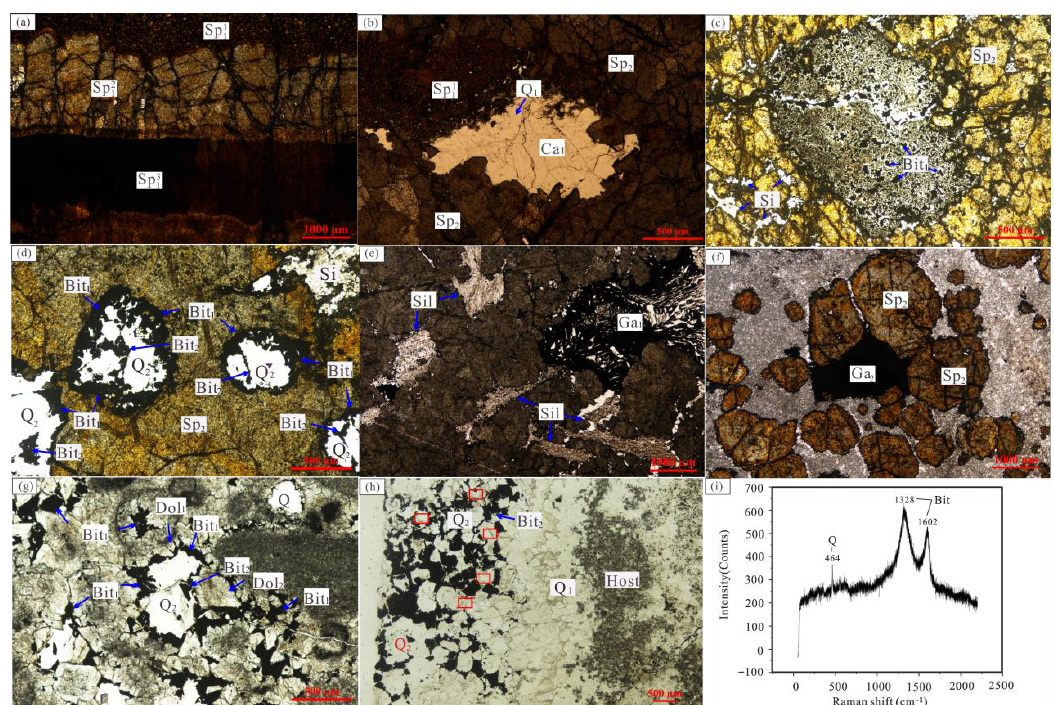
Figure 5. Photomicrographs and Raman spectroscopic analysis of mineral generation relationships. ( a ) The early spherical sphalerite precipitated in a cavities, and the filling order is fine granular sphalerite (Sp 11 ) → dentate sphalerite (Sp 12 ) → comb-shaped sphalerite (Sp 13 ) from the edge to the center; ( b ) The early granular sphalerite (Sp 11 ), early quartz (Q 1 ) and calcite (Ca 1 ) are encapsulated in late sphalerite (Sp 2 ); ( c ) The host rocks, such as bituminous (Bit 1 ) silicified dolostone and siliceous rock (Si), are encapsulated in late sphalerite (Sp 2 ); ( d ) The host rocks, such as pore space fillings and siliceous rock (Si), are encapsulated in late sphalerite (Sp 2 ); among them, two generations of bitumen (Bit 1 , Bit 2 ) can be identified in the pore fillings, suggesting that this sphalerite (Sp 2 ) was formed at the end of the late mineralization; ( e ) The host rocks, such as siltstone (Sil) and early galena (Ga 1 ), are encapsulated in late sphalerite (Sp 2 ); ( f ) Late banded sphalerite (Sp 2 ) is paragenetic with granular galena (Ga 2 ); ( g ) The generation relationship of gangue minerals is that the pore was filled with early dolomite (Dol 1 ) → early bitumen (Bit 1 ) → late bitumen (Bit 2 ) + late quartz (Q 2 ) + late dolomite (Dol 2 ) from the edge to center of the pore; ( h ) The generational relationship of gangue minerals is that the pore was filled with early quartz (Q 1 ) → late bitumen (Bit 2 ) + late quartz (Q 2 ) from the edge to center of the pore. The early quartz (Q 1 ) is xenomorphic granular and has no inclusions. The late quartz is euhedral-subhedral and conical, with abundant banded bitumen inclusions; the red frame shows the position of Raman spectrum analysis of inclusions in late quartz; ( i ) Raman spectroscopic analysis of bitumen inclusions in late quartz (Q 2 ). Quartz tested for analysis is marked with red boxes in ( h ). Sp sphalerite, Ga galena, Py pyrite, Q quartz, Bit bitumen, Ca calcite, Dol dolomite, Si siliceous, Sil silty mudstone, Host